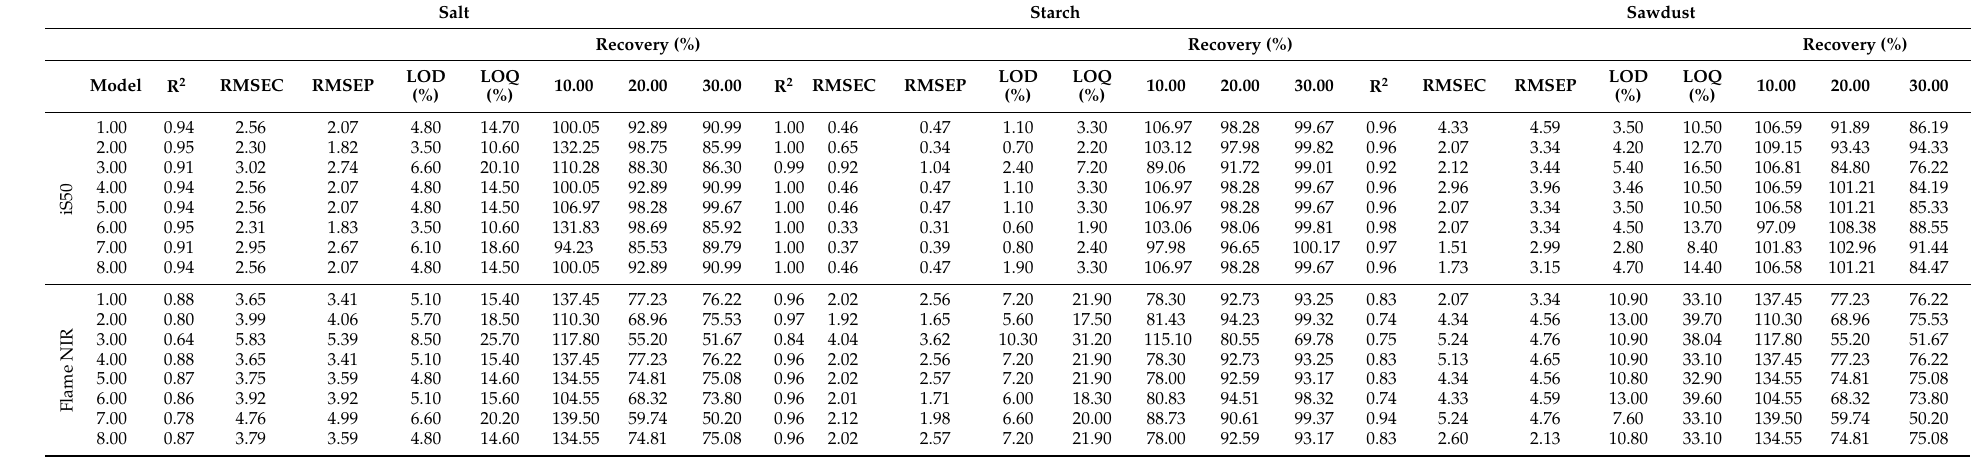
Table 4. Statistical parameters determined from PCR models developed using TQ Analyst software with spectral data obtained from the iS50 and Flame-NIR instruments. Salt Starch Sawdust Recovery